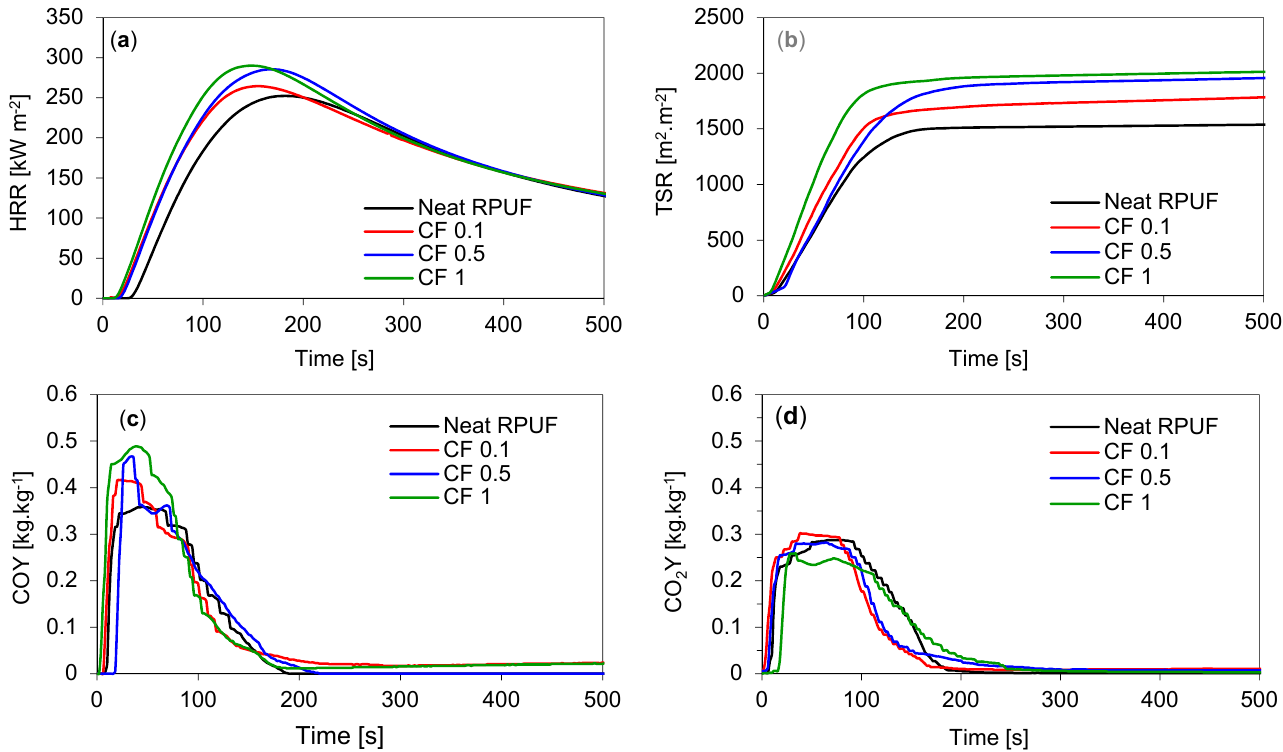
Figure 8. Results from cone calorimetry tests for the studied RPUF composites. ( a ) Heat release rate curve (HRR), ( b ) total smoke release curve (TSR), ( c ) average yield of CO, and ( d ) average yield of CO 2 .